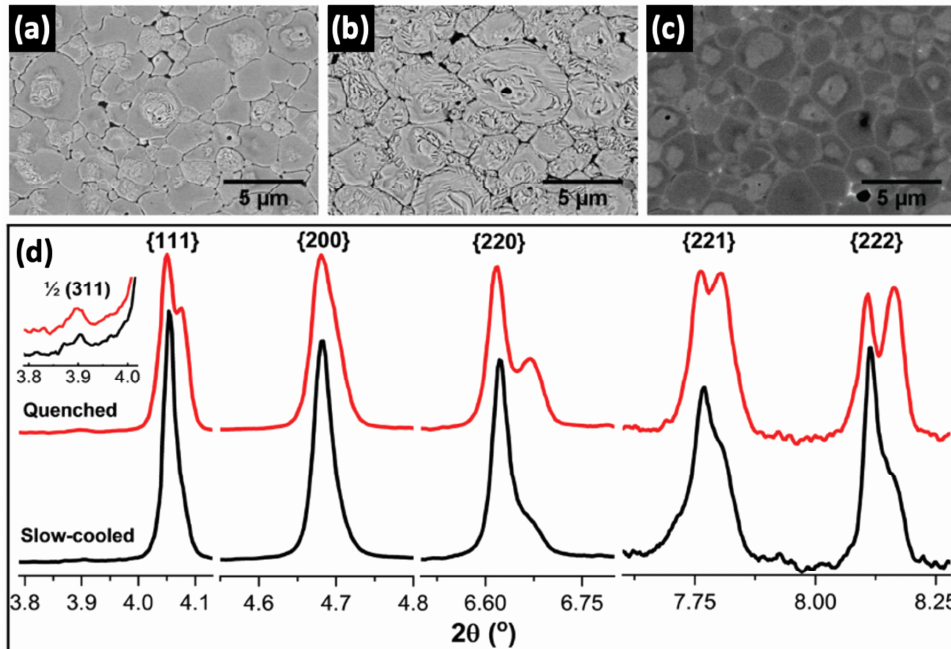
Figure 16. SEM images and high-energy XRD patterns of the 1 mol% Ti-doped 0.75BF–0.25BT ceramics. Chemically-etched surfaces of ( a ) slow-cooled and ( b ) quenched ceramics, and ( c ) non- etched polished surface of the quenched ceramic. ( d ) High-energy XRD profiles of slow-cooled and quenched ceramics for given crystallographic orientations. Reproduced from [77] with permission from the Royal Society of Chemistry.